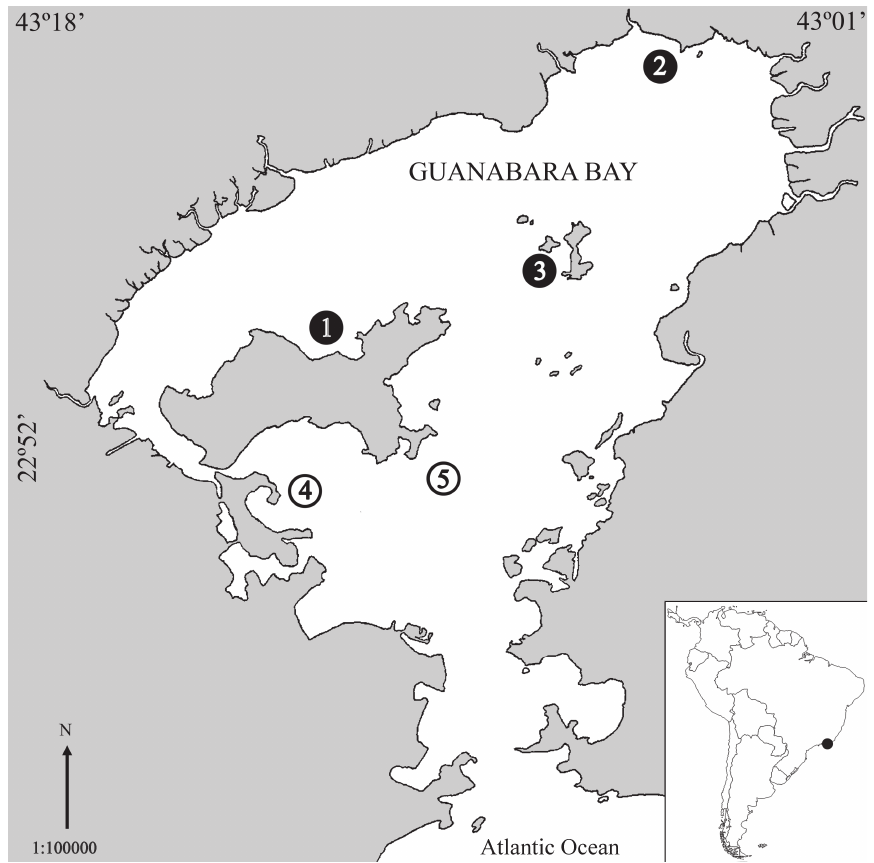
Fig. 1. Guanabara Bay, Rio de Janeiro, Brazil, indicating the sampling stations: 1- Bancários, 2- Magé, 3- Paquetá Island, 4- Fundão Island, 5- central channel. Black circles indicate artisanal fishing landing sites and white circles indicate experimental sampling